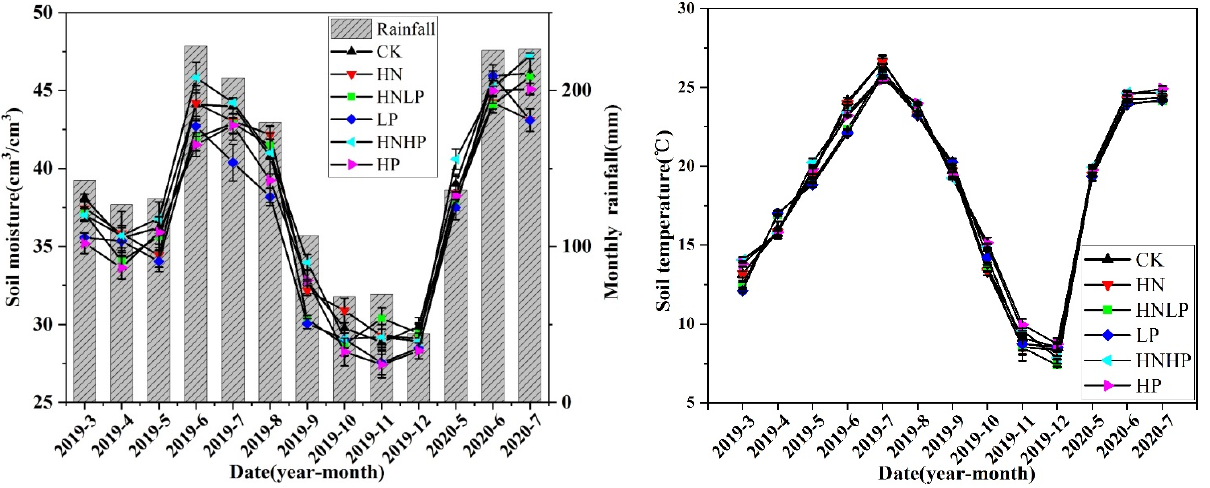
Figure 2. Monthly soil moisture (cm 3 /cm 3 ) and rainfall (mm; left) and soil temperature (°C; right) under different treatments. Error bars denote the standard deviations ( n = 4). Table 1. The carbon and nutrient concentrations in the Chinese fir plantation under different treatments. Note: the numbers in the parenthesis are the standard deviations ( n = 5). Different letters between treatments denote significant ( p < 0.05) differences.